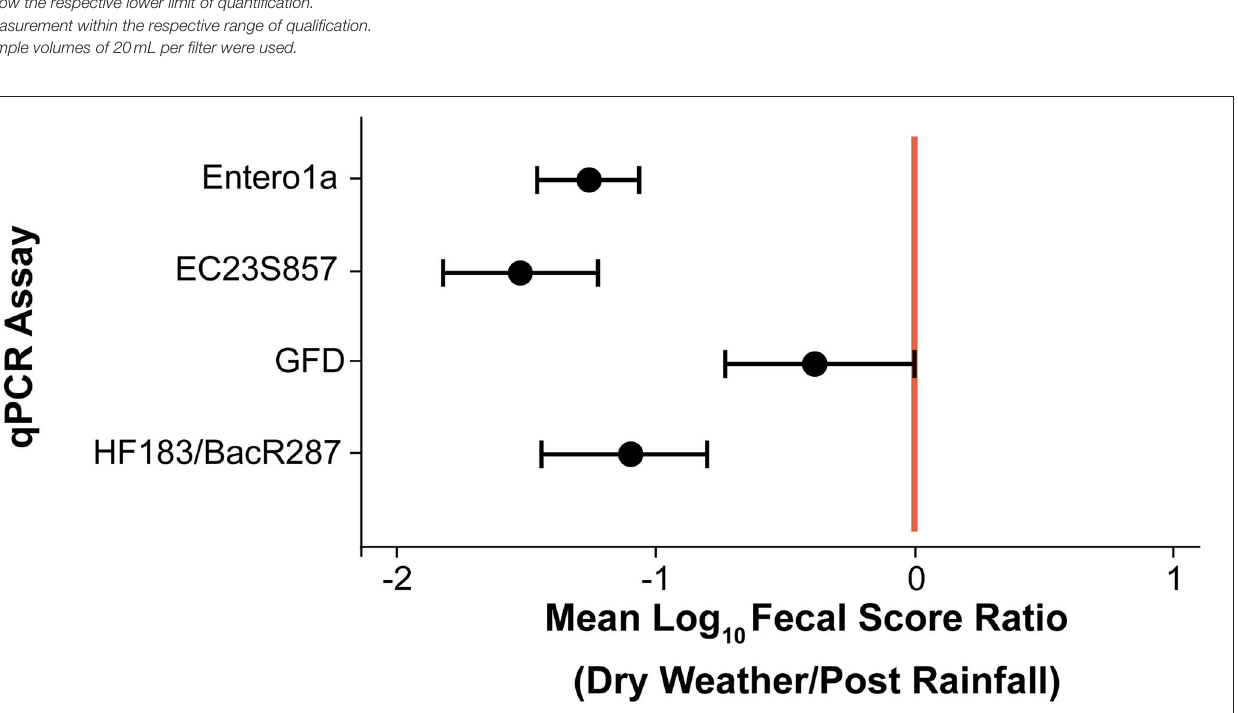
qPCR counts when no-detection (ND) was obtained, detections below LLOQ (BD), and within the range of quantification (ROQ) organized by sampling event type (post rainfall/dry weather) are given. a no-detection. b below the respective lower limit of quantification. c